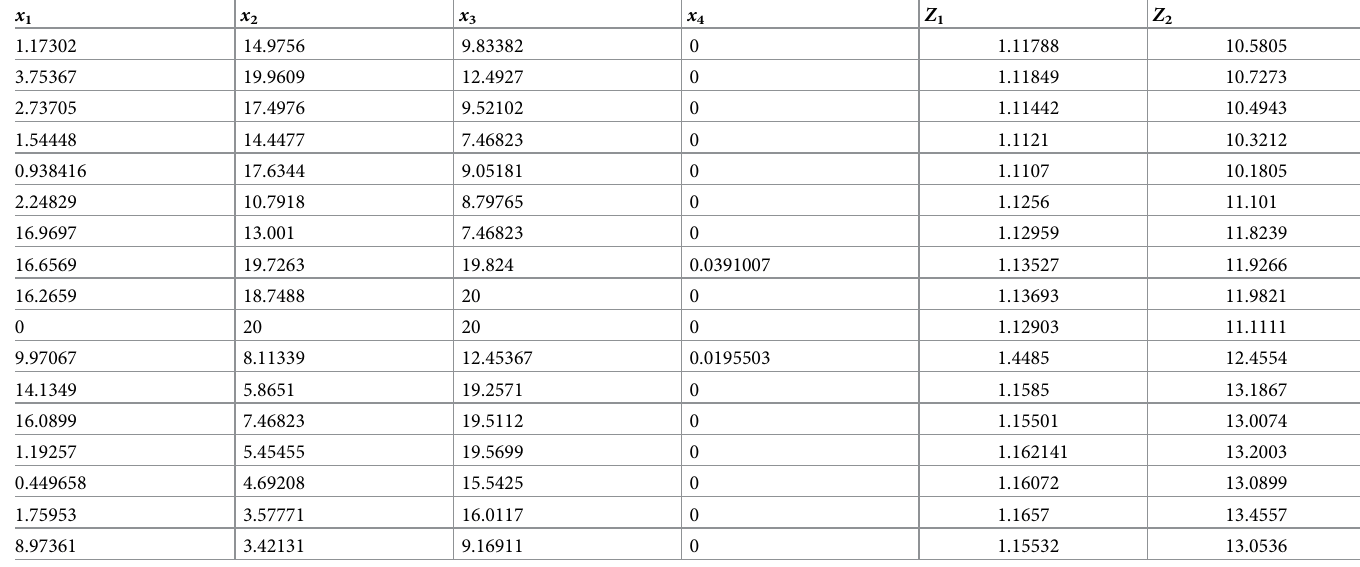
Table 3. Non dominated solutions and values of Z 1 and Z 2